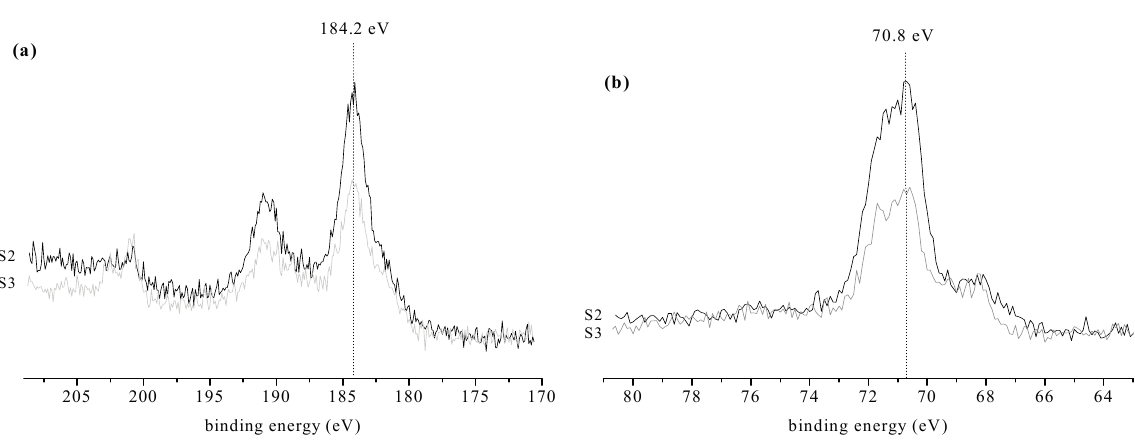
Figure 2. High resolution XPS spectra for the S2 and S3 samples in the regions: ( a ) Br 3p and ( b ) Br